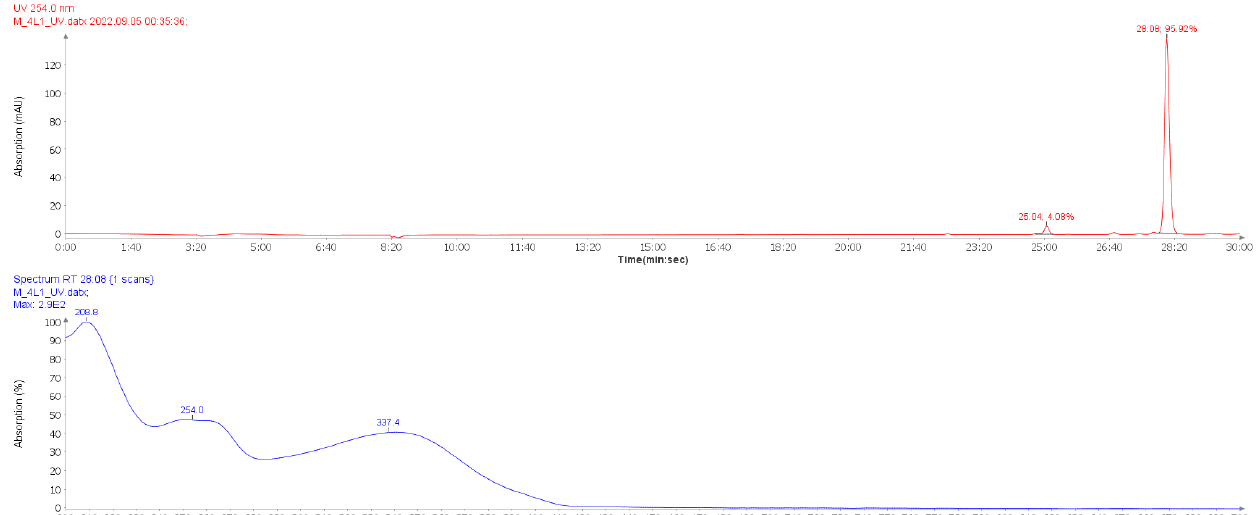
Figure 1. HPLC chromatogram (top) and HPLC-UV spectrum of compound 4 . The chromatogram label 28:08 indicates the sample retention time (minutes: seconds) while 95.92% indicates the percentage purity of compound 4 .